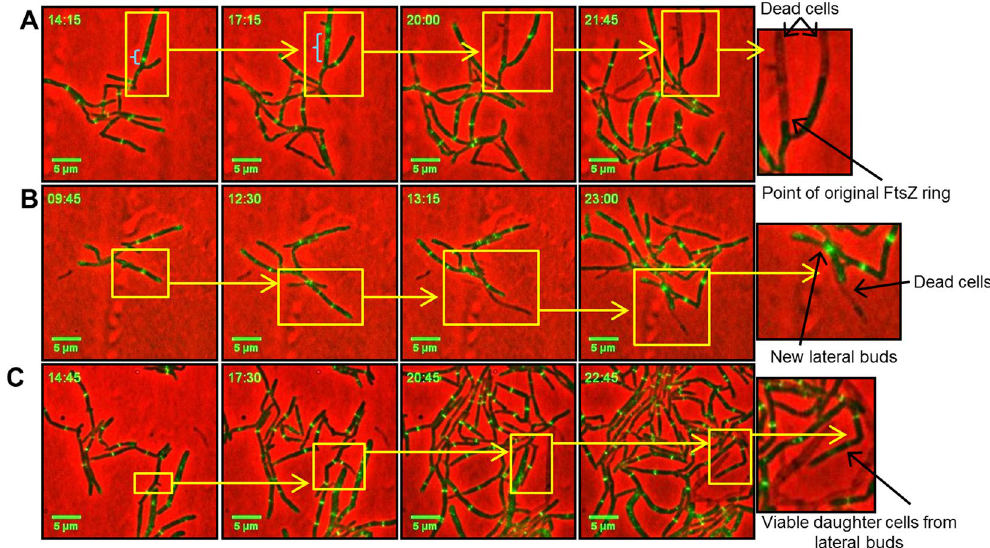
Figure 5. Time-lapse microscopic analysis of the Δ ami1 mutant carrying FtsZ-rsEGFP. Cells were monitored for FtsZ bundling around lateral buds. ( A ) Video stacks depicting the progression of lateral buds (yellow rectangles), followed by death of the mother cell, at the point from which the original FtsZ ring was formed (blue parenthesis), and death of one daughter cell that resulted from the lateral bud. ( B ) Depicts the progression of two lateral buds, followed by death of one bud and half of the original mother cell. Thereafter, two new buds appeared over the husks of these dead cells. ( C ) Depicts the formation of a lateral bud that proceeded to form a viable daughter cell. Scale bar = 5 µ m. Time frame is in hours.